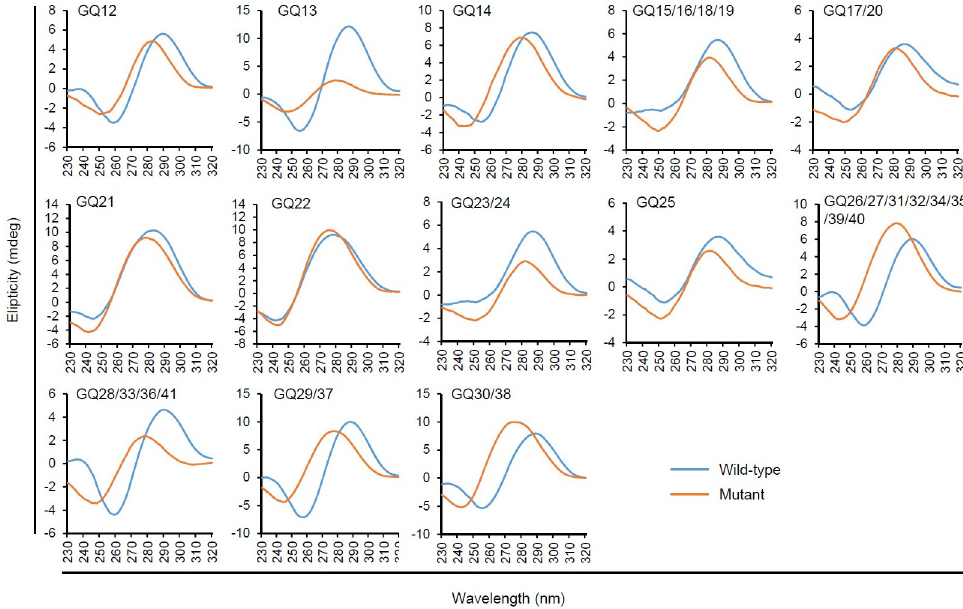
Fig 3. CD spectroscopy analysis of ORF14 GQ ODNs from pOka. CD spectra of wild-type and mutant ORF14 GQ ODNs (15 μ M) from pOka annealed in 10 mM Tris-HCl pH 7.5 and 100 mM KCl are shown. Each spectrum was an average of three accumulations in the wavelength range between 230–320 nm. The spectra were blanked with buffer only. GQ15/16/18/19 and GQ23/24 are same sequences, but their mutant sequences are different. Similarly, GQ17/20 and GQ25 are the same sequences, but their mutant sequences are different. The data were normalized using the maximum ellipticity and smoothed using GraphPad Prism 5.